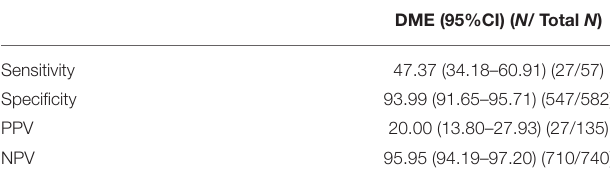
TABLE 3 | CARE performance for detecting